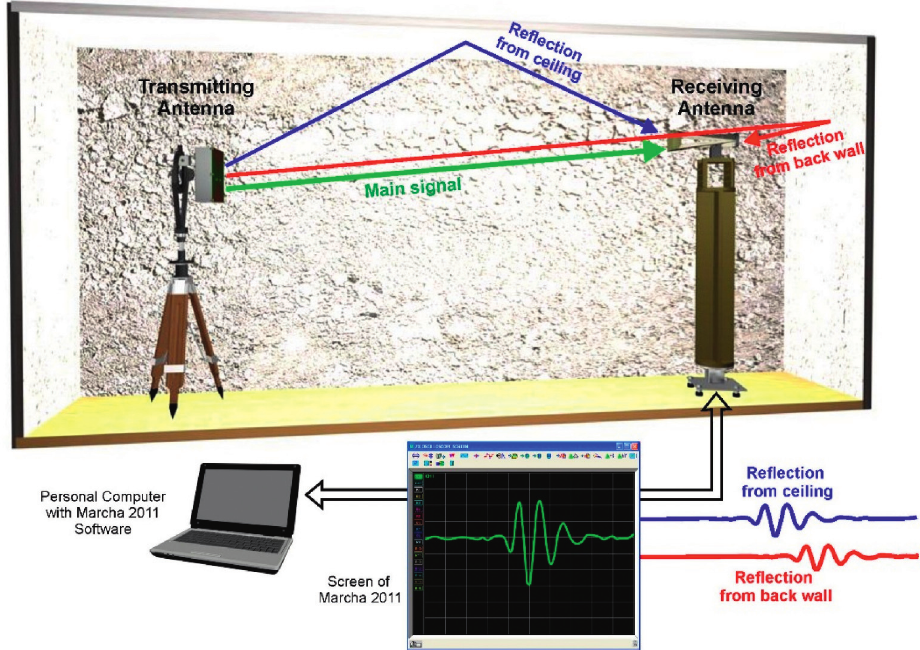
Figure 6: Measurement setup for the radiation